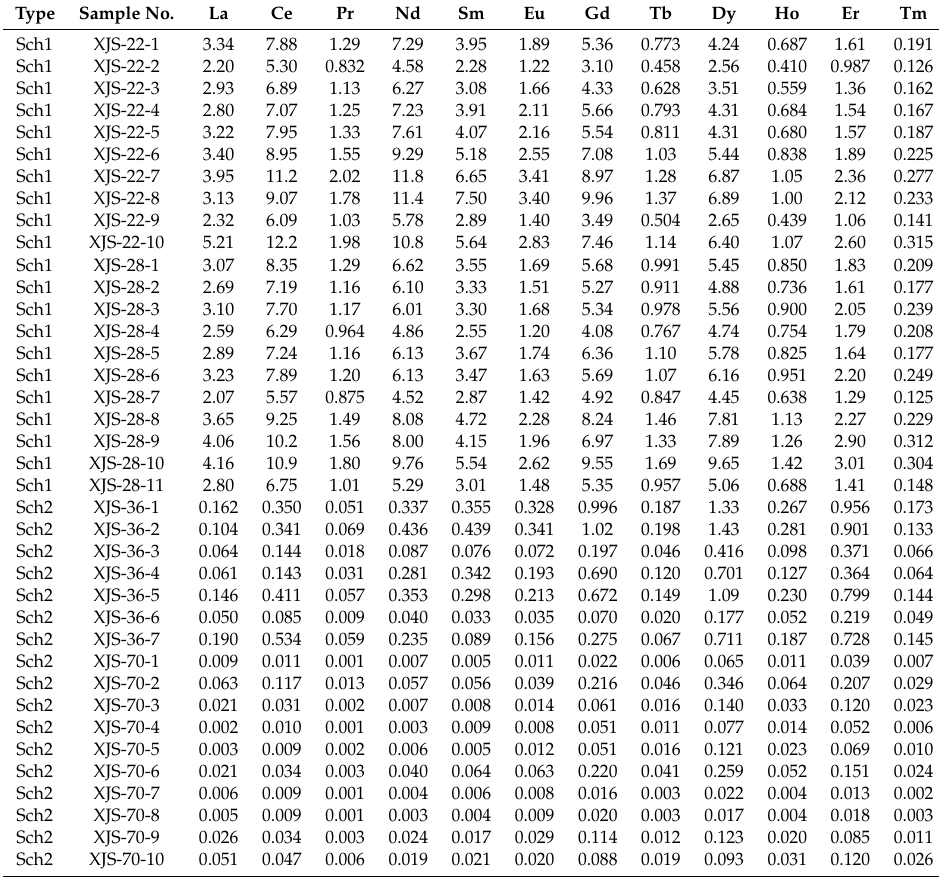
Table 1. REE and trace element compositions (ppm) of scheelite from the Longshan Sb-Au deposit, South